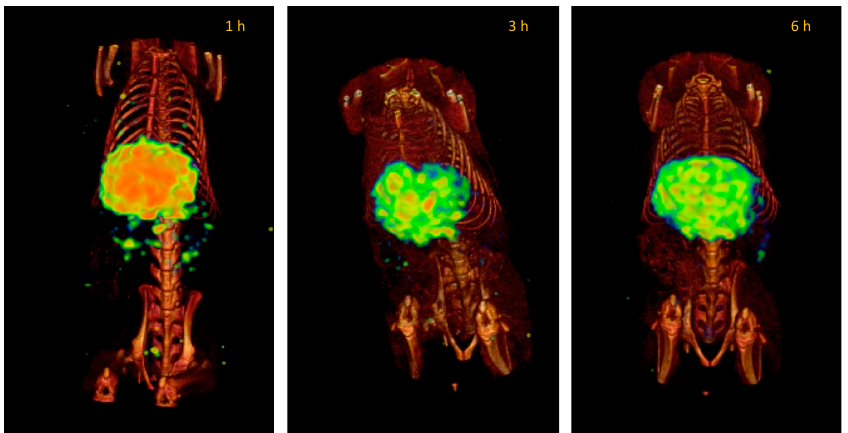
Figure 10. Representative SPECT/CT images of the lipomics’ biodistribution at 1, 3, and 6 h after injection in healthy rats. The accumulation mainly occurs in the liver. Images are from the same rat.